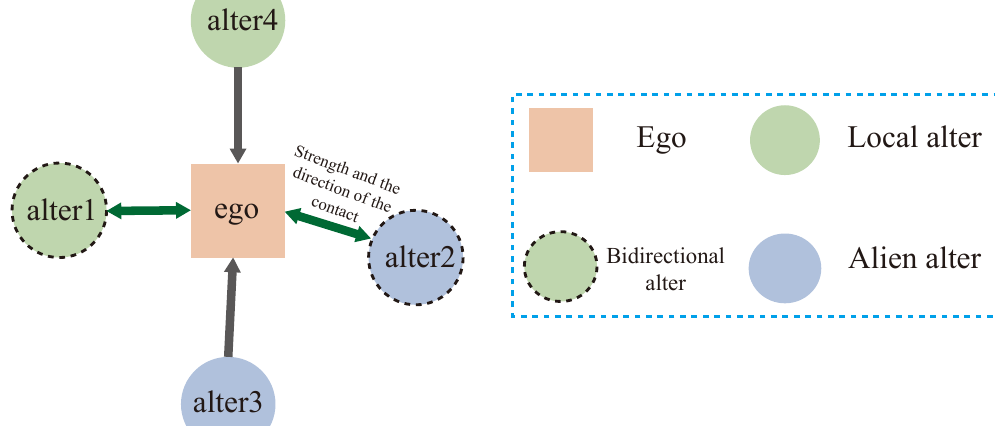
Figure 1. Data structure for social model based on egocentral network. The square box represents the ego and the color of the box indicates which group the ego belongs to. The color of the circle indicates whether they have something in common. The length of arrow tells us the relationship between ego and the alter. The color of an arrow represent the direction of contact. The dotted border indicates the alter is a bidirectional